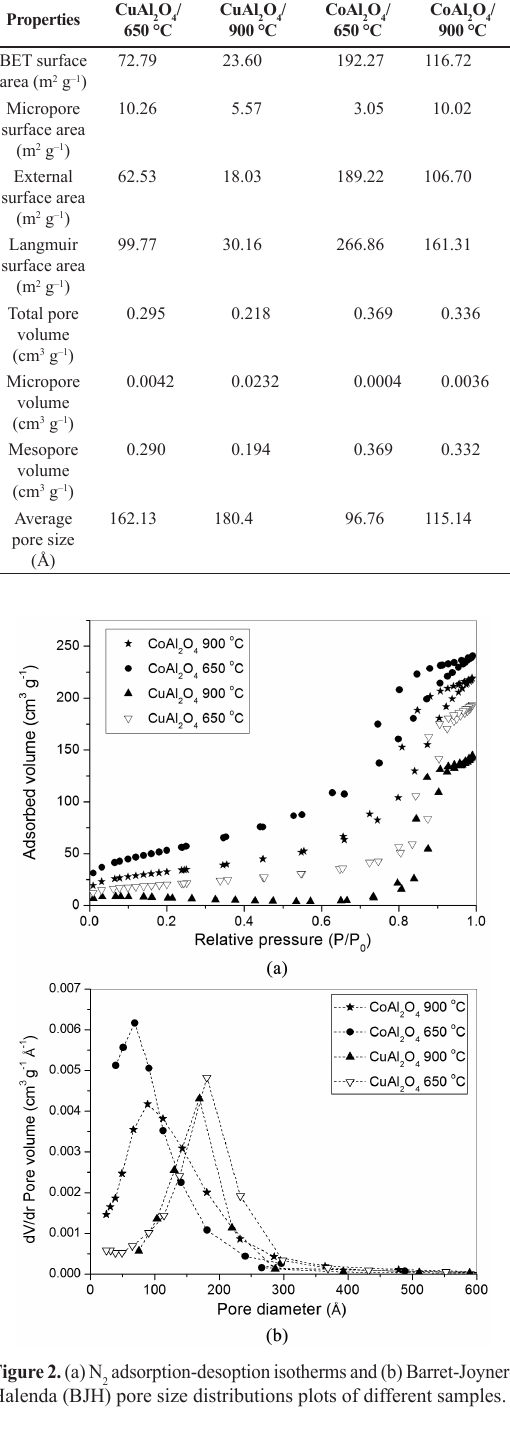
Table 1. Surface physical characteristics of oxide samples prepared at different